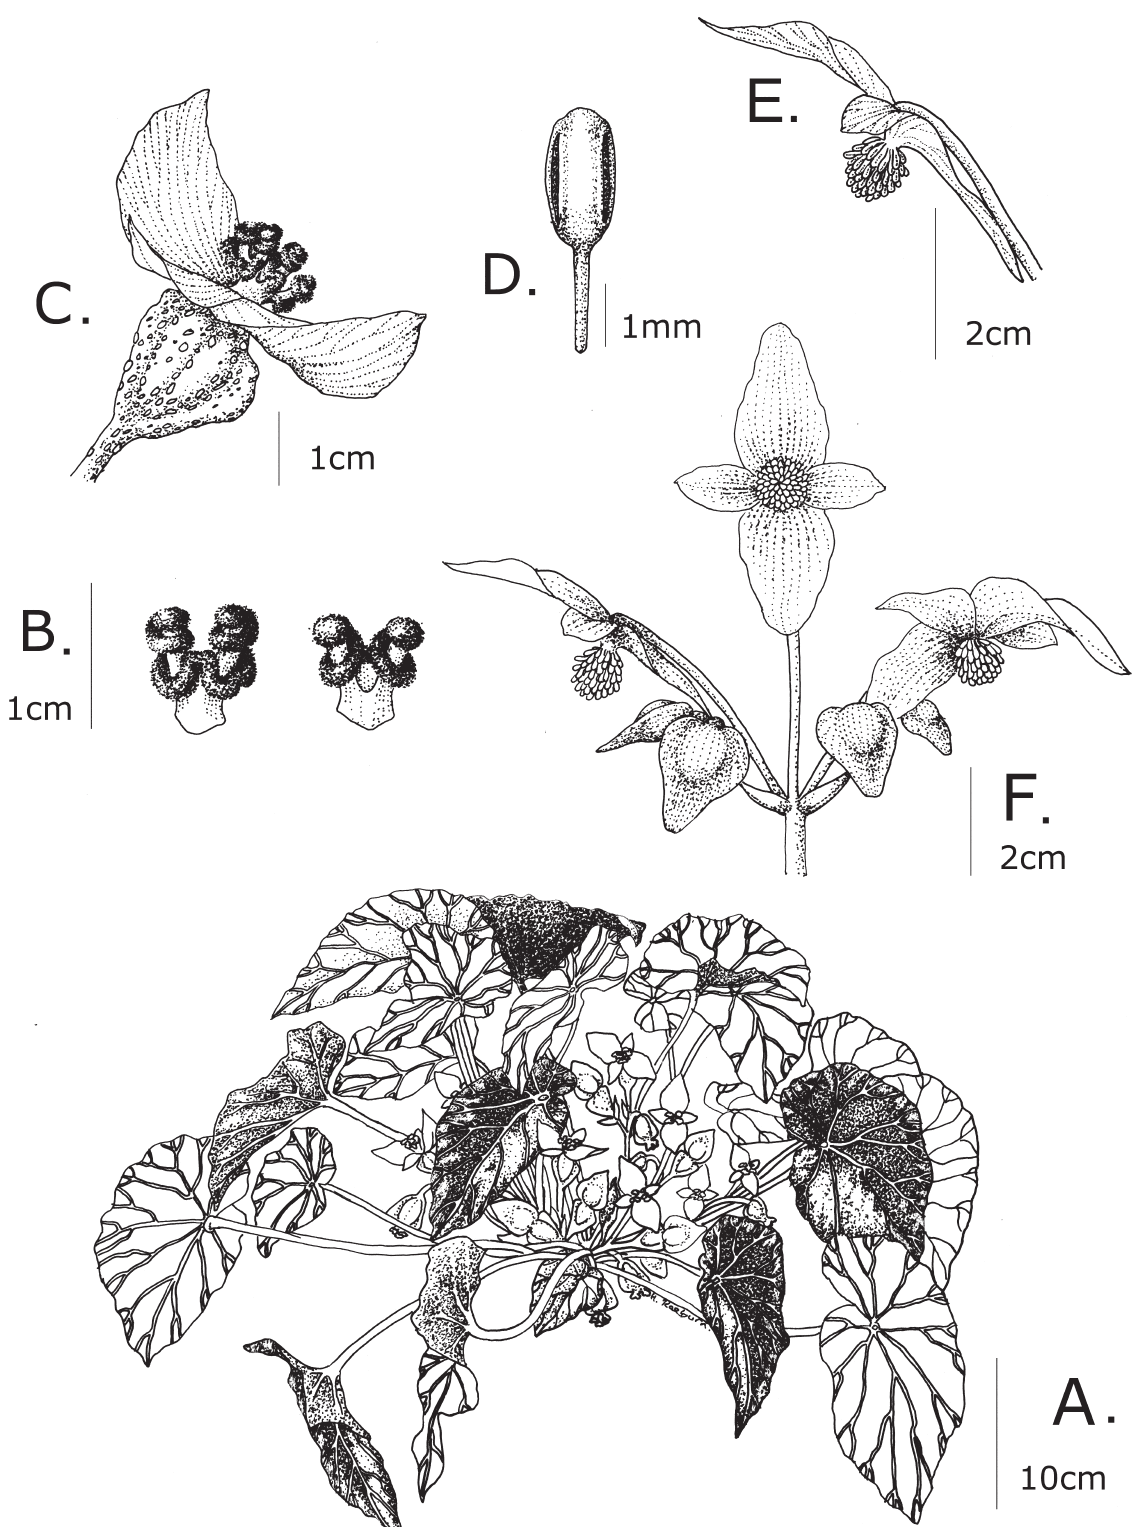
Fig. 18. Illustration of B. burkillii Dunn. A . Habit of plant. B . Style. C . Female flower. D . Stamen. E . Male flower. F . Male inflorescence. Drawn by Heather Raeburn. A–C from Burkill 36720 ; D from Burkill 37455 ; E–F from Burkill 37139 ; all